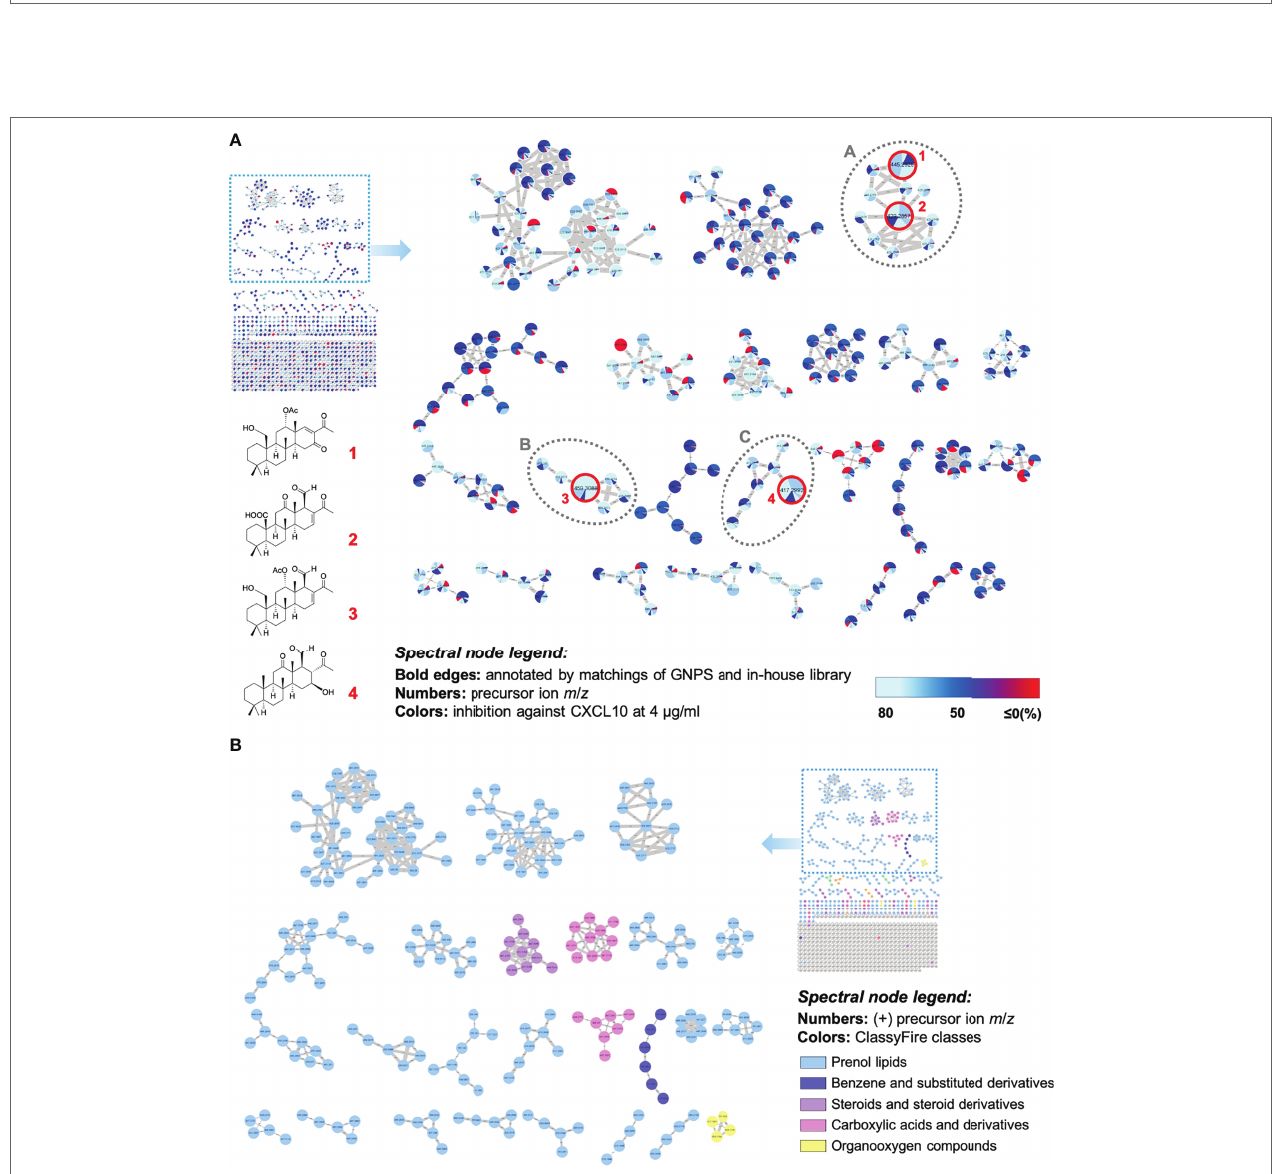
FIGURE 3 | The CRL-3390 neurofibroma cell viability at various concentrations (2, 4, and 8 μg/ml) of BRW1–11 treatments. Results are presented as mean ± S.E.M. (n = 5). **** p < 0.0001 compared with the control (DMSO).